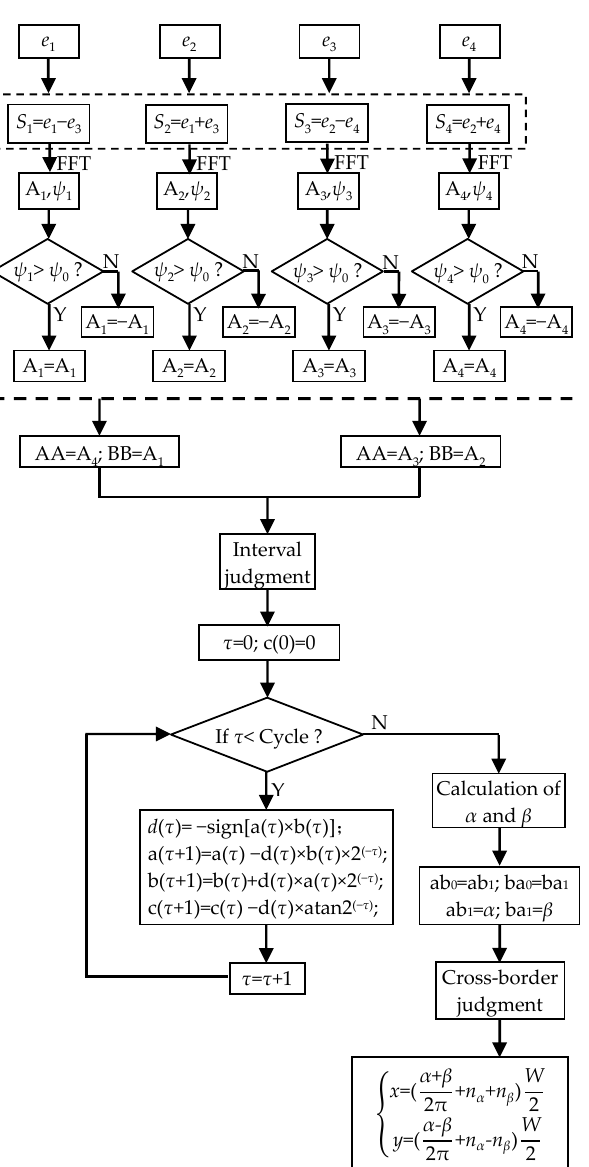
Figure 7. Algorithm flowchart.